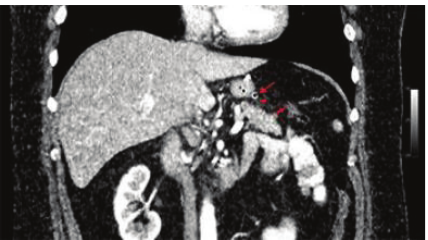
Figure 1: Long arrow: the drain; short arrow: pancreatic corpus; arrow head: focal contamination on the fatty tissue between the pancreas and drain.